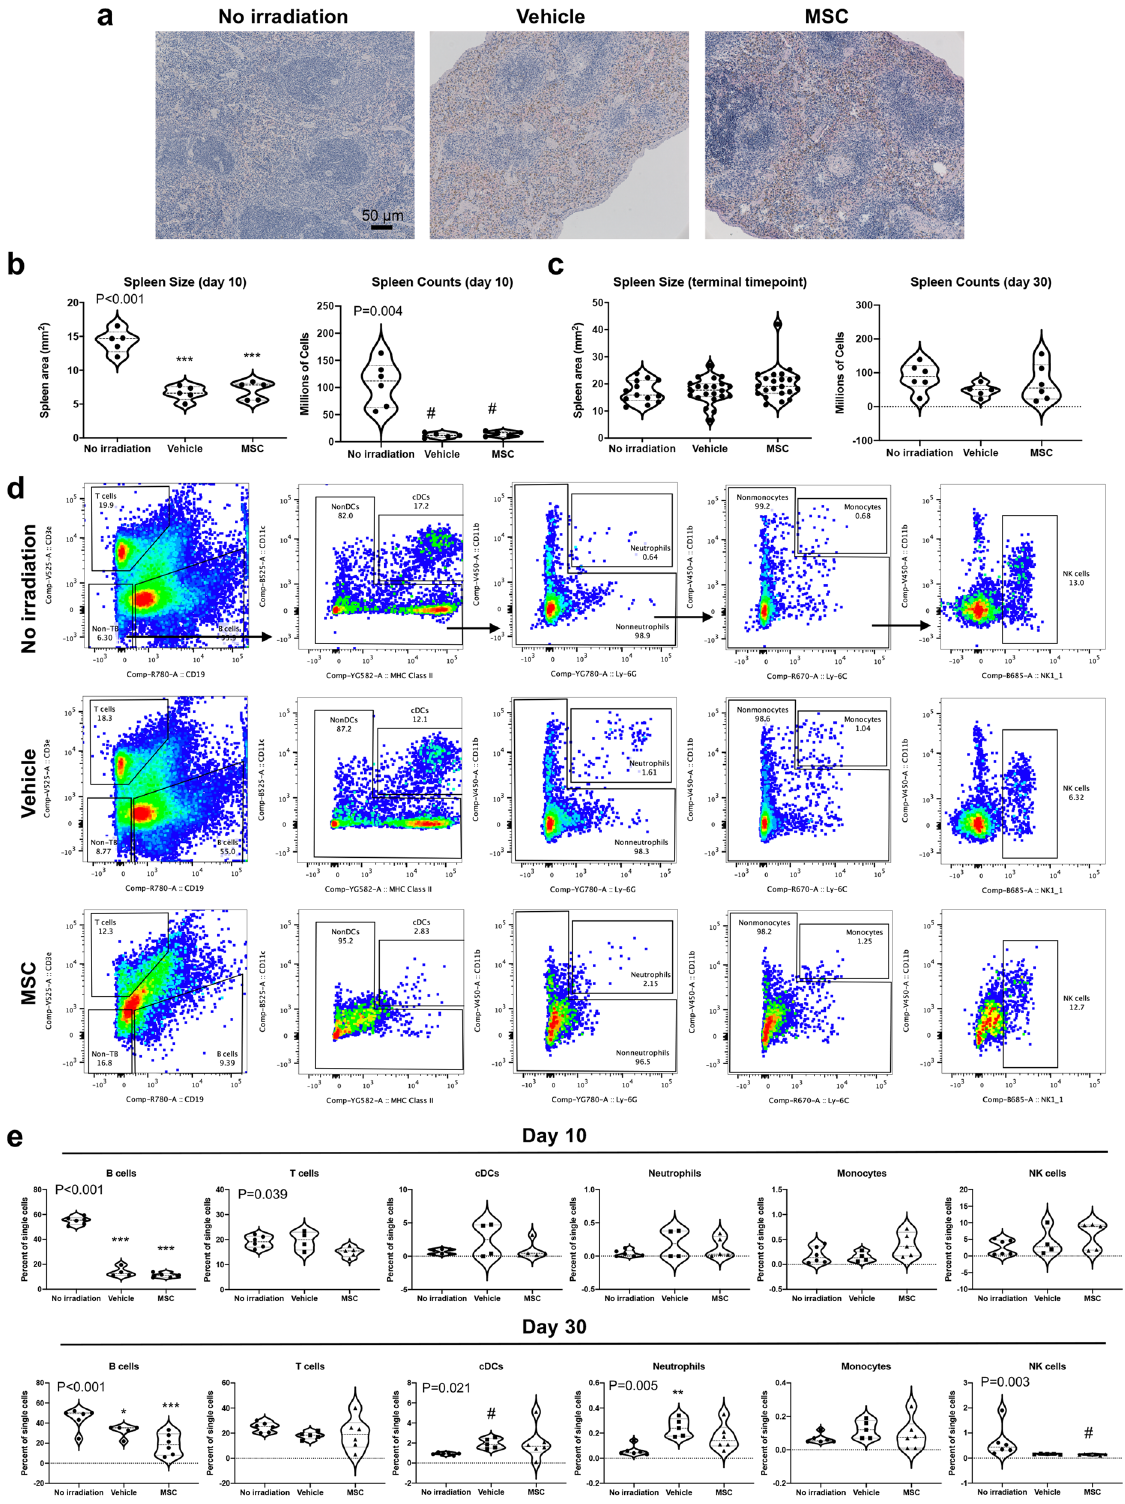
Figure 2. Radiation injures the spleen and alters immune cell composition. ( a ) H&E staining of the spleen at day 10 reveals fibrosis and visible hemosiderin, indicative of breakdown of red blood cells, in the irradiated mice regardless of whether they received vehicle or MSCs. ( b ) Splenic cellularity and size 10 days after irradiation are reduced but are indistinguishable in irradiated and unirradiated mice ( c ) at the terminal time point. ( d ) Representative flow cytometry plots of gating for immune cell lineages, including B and T lymphocytes, dendritic cells (cDCs), neutrophils, monocytes, and NK cells. ( e ) Quantification of splenic immune cell composition at day 10 and day 30. Statistical significance of differences between groups is depicted on the graphs. Posthoc comparisons are demarcated by asterisks * P < 0.05, ** P < 0.01, and *** P < 0.001 for Holm–Sidak (One-way ANOVA) or pound symbol # P < 0.5 for Dunn’s (Kruskal–Wallis One-way ANOVA) analyses relative to No irradiation